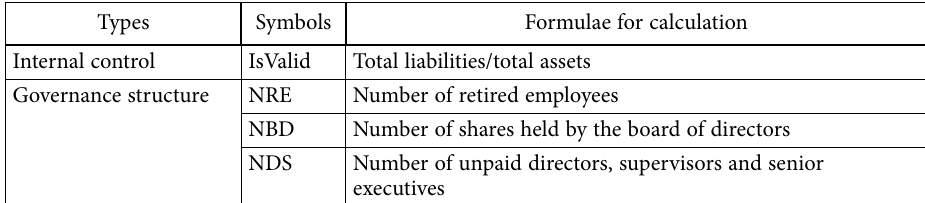
Table 5. Non-financial indicators for distress